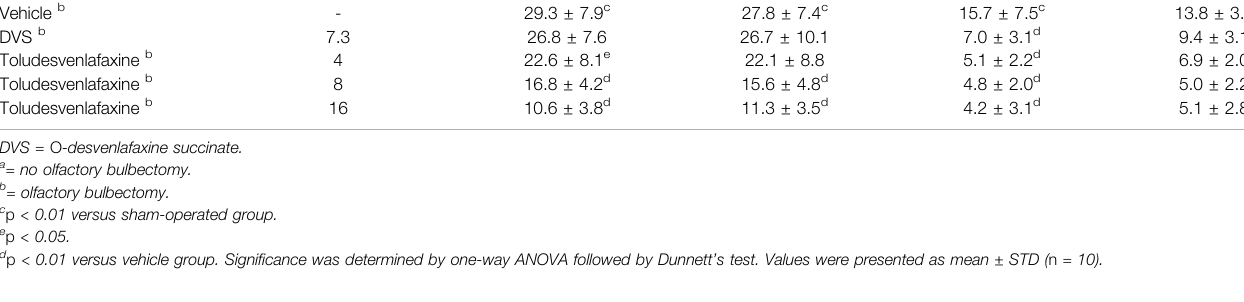
TABLE 4 | Effects of toludesvenlafaxine on sugar consumption, serum corticosterone and testosterone levels in olfactory bulbectomized rats. Group Dose (mg/kg) Sugar consumption rate